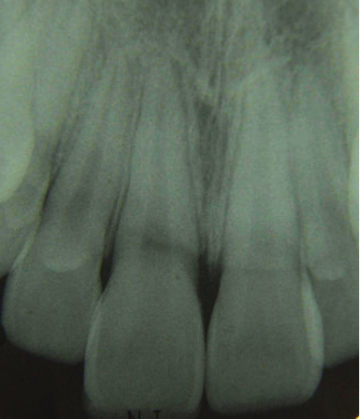
Figure 4: Acid etching on enamel and dentin.